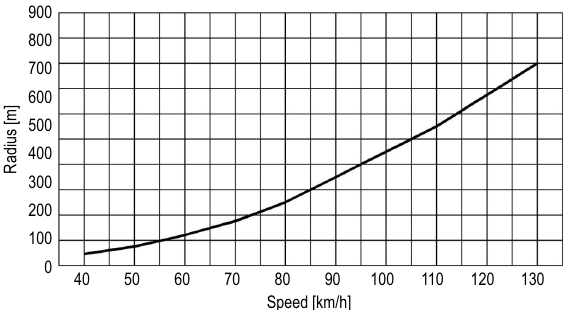
Fig. 3. Relation between the radius of a horizontal curve and the speed (Putevi Srbije 2011)